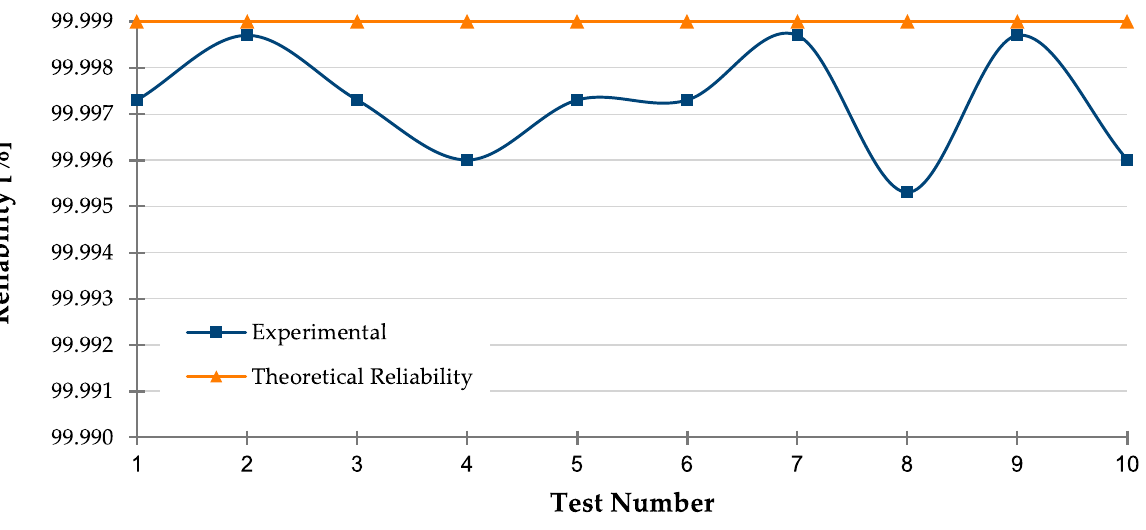
Figure 7. Comparison of expected (orange) vs. measured D2D reliability in 5G-NSA.